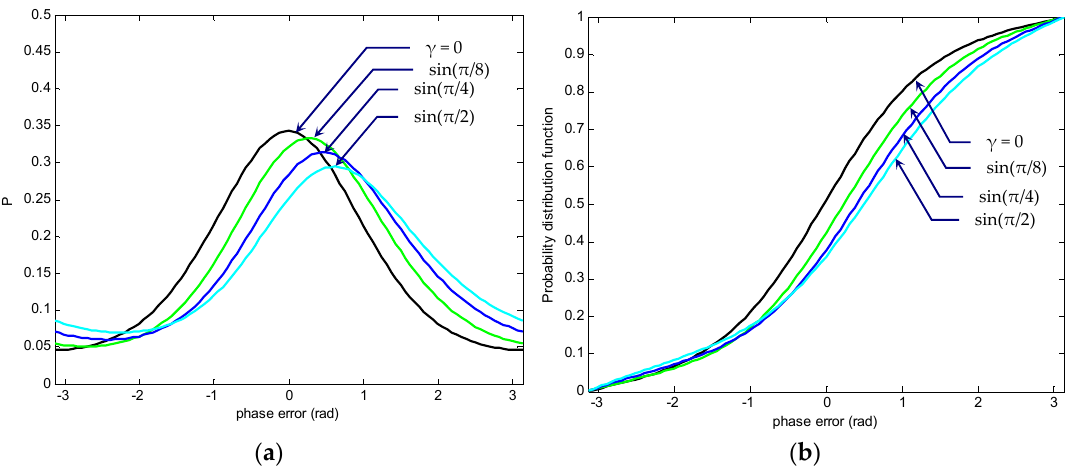
Figure 18. Variation of modulo-2 π phase-error steady state: ( a ) PDF and ( b ) cumulative probability distribution function, for SNR α = 1 with various detuning factors γ ( τ ≥ 5 or steady-state).